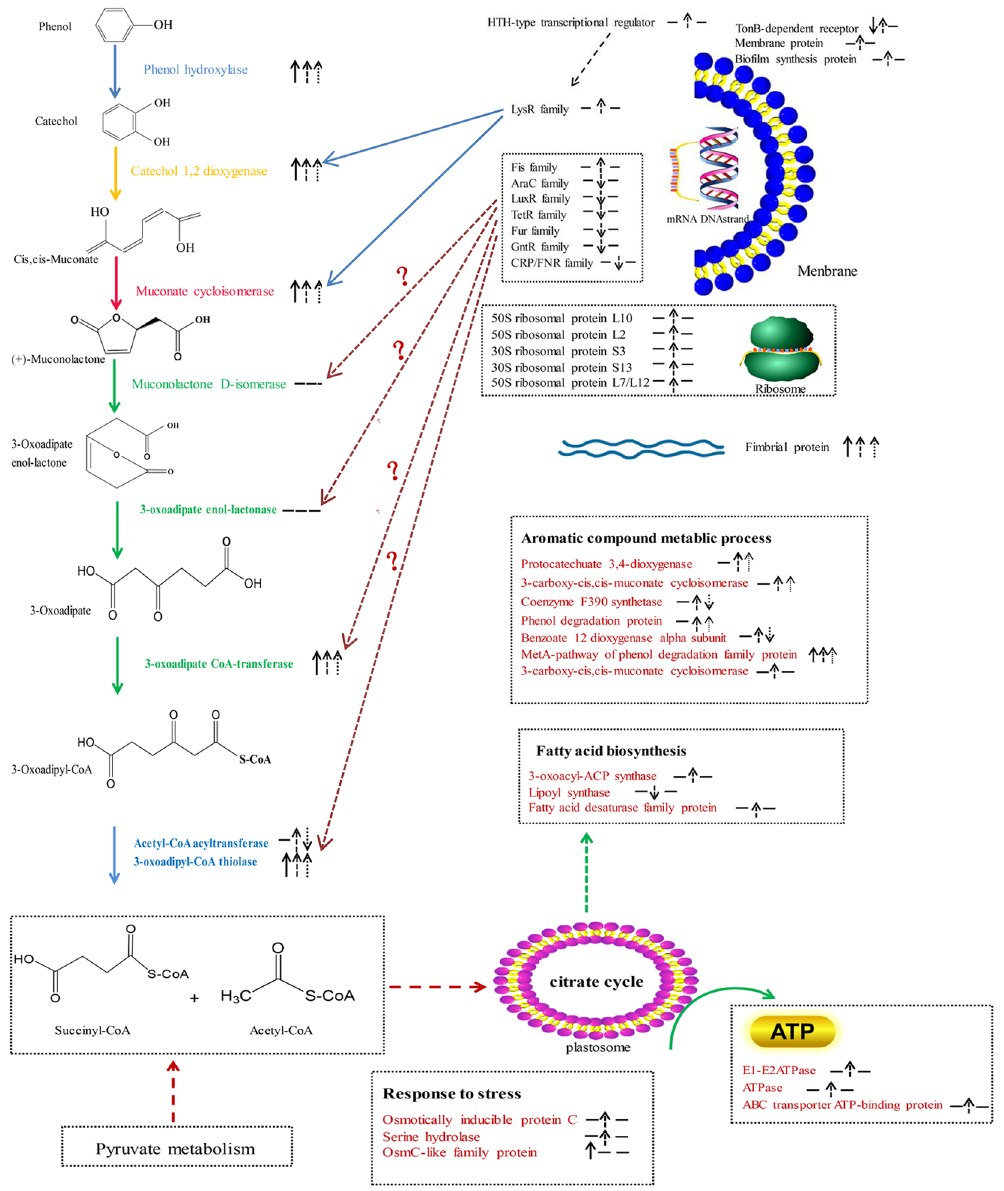
Figure 9. The metabolic pathway of phenol biodegradation. The proteins and genes identified by 2-D electrophoresis and RNA-seq, and the variation of them in the state of regulation are indicated by arrows(up/ down), “ ”represents the state of proteins detected by 2-D electrophoresis, “ ”represents the state of genes detected by RNA-seq. “ ”represents the state of proteins or genes validated by RT-qPCR. “ − ” represents none